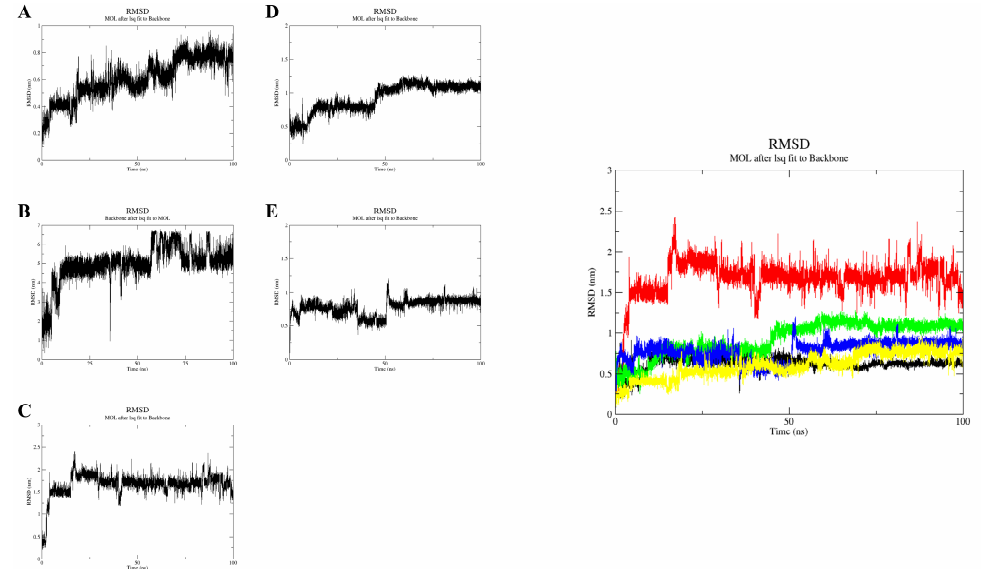
Figure 8. RMSD plot (individual trajectory) of resveratrol ( A ); bisphenol A ( B ); 17 β -estradiol ( C ); G-1 ( D ); G-15 ( E ). RMSD plot (merged trajectories) of resveratrol (yellow); bisphenol A (black); 17 β -estradiol (red); G-1 (green); G-15 (blue).